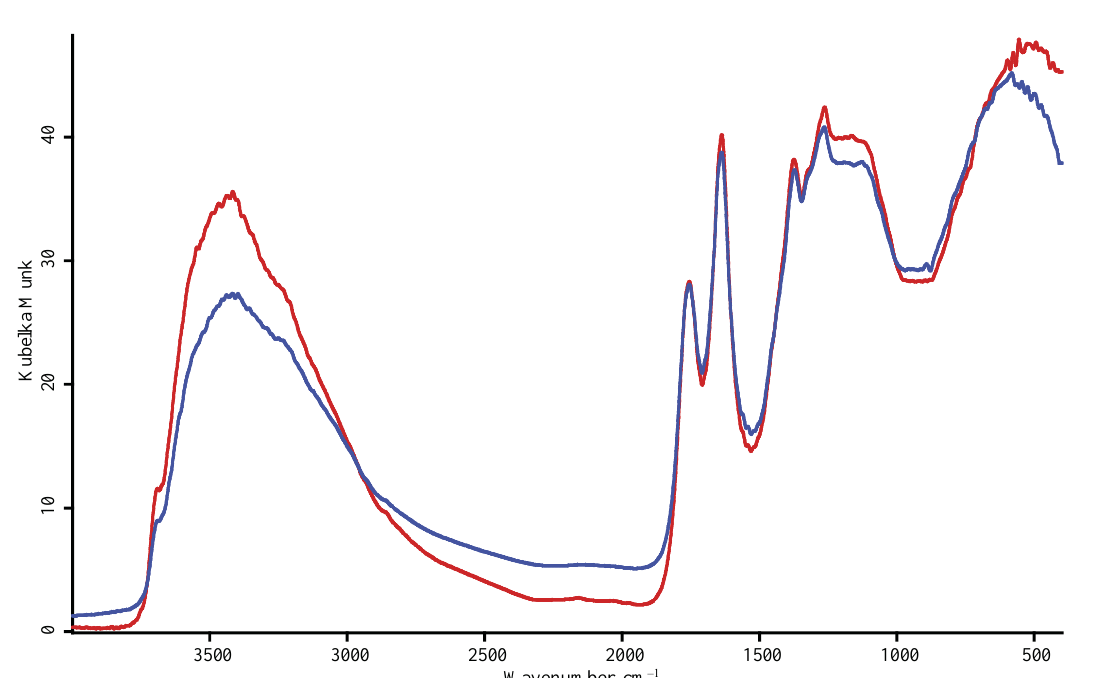
Figure 8. Diffuse reflectance mode, DLaTGS detector, RUDDM nanodiamonds; red, PrayingMantis mirror was used for background collection; blue, KBr in the sample cup was used for background collection. Spectra are smoothed (13 points) and normalized to maximize each spectrum.